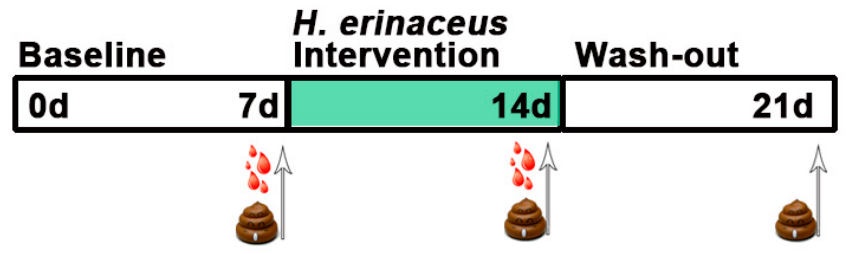
Figure 1. Brief timeline of the study design and sampling. Each of the three phases of the experiment was maintained for a week as follows: baseline, a phase to balance some stimulus which may affect the samples; intervention, a period to consume H. erinaceus powder with the daily diet; and wash-out, the final stage to remove H. erinaceus powder from the daily diet and maintain a regular diet. Samples were taken prior to the start of the next phase.